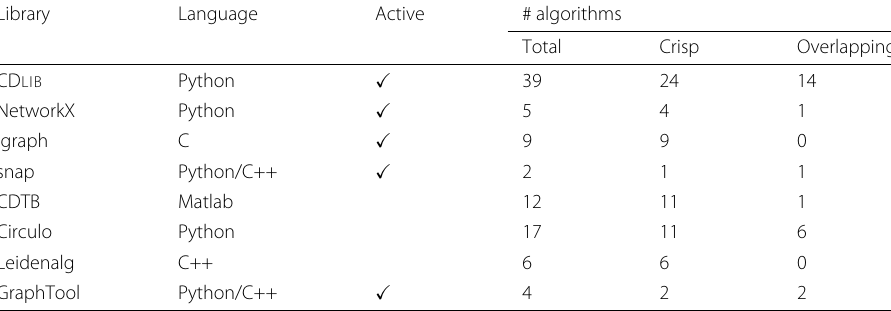
Table 5 Number of methods available in the main competitors of CD LIB